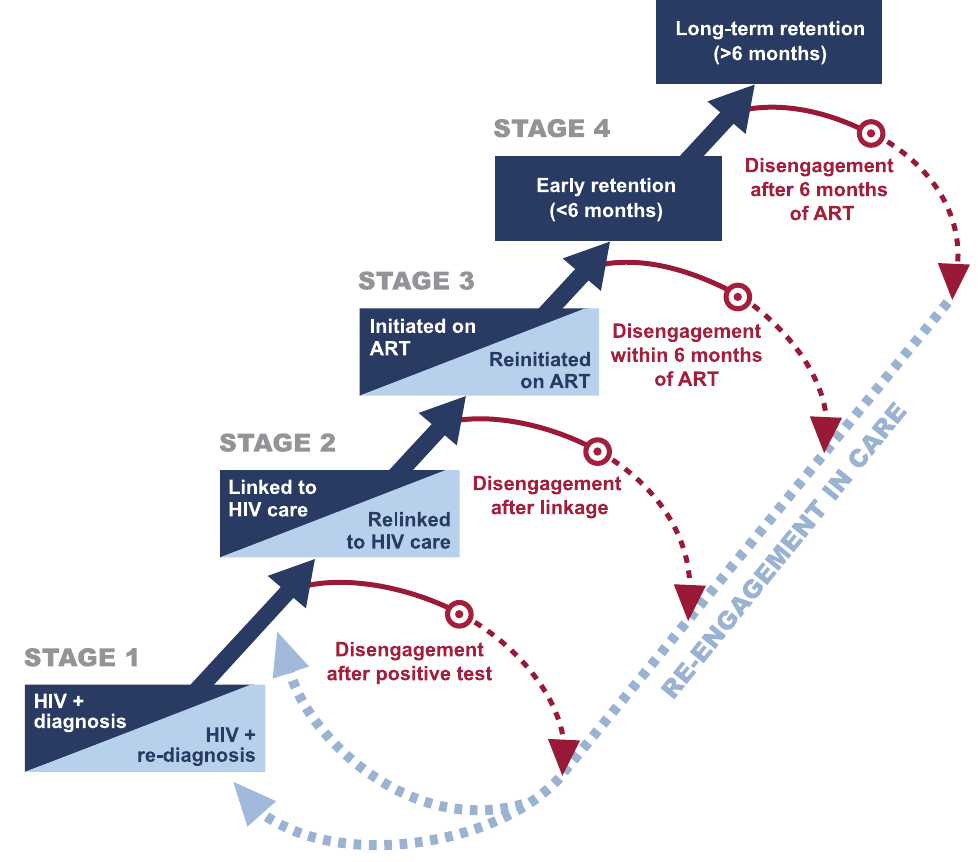
Fig 1. Cyclical cascade of HIV care. ART, antiretroviral therapy; HIV, human immunodeficiency virus.